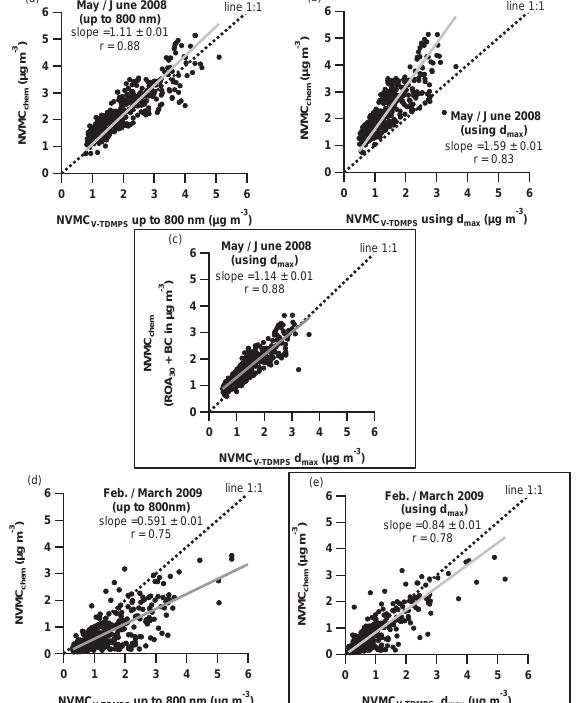
Figure 5. Comparison of the estimated (NVMC est ) with the measured (NVMC meas ) non-volatile particle mass concentration (NVMC). Three different approaches were used to estimate the non- volatile particle mass fraction; using the full V-TDMPS size range, (up to 800nm) or a time-dependent upper size cutting ( d max ) and fi- nally for May–June 2008, the non-volatile organic aerosol (NVOA) was also estimated based on only 30% of the measured LV-OOA (NVOA 30 ) . The two encased scatterplots correspond to the better solution obtained for each periods (see text for discussion).